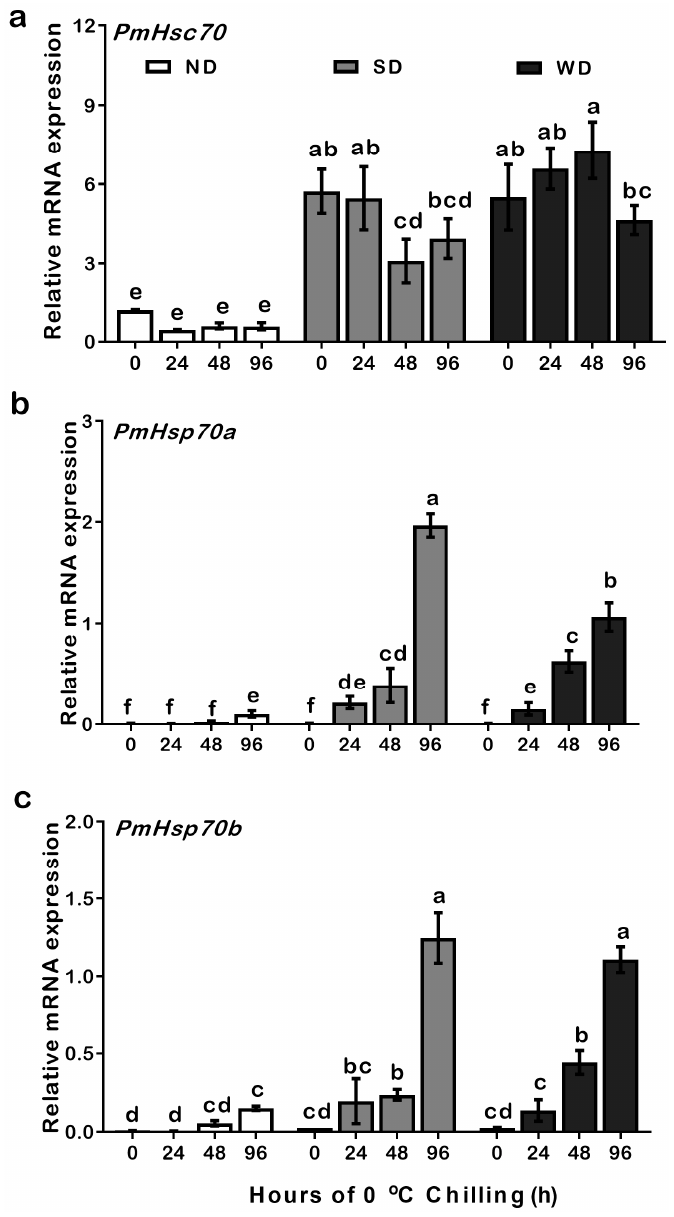
Figure 4. Relative mRNA expression levels of PmHsc70 ( a ), PmHsp70a ( b ), and PmHsp70b ( c ) in re- sponse to low-temperature cryogenic chilling at 0 °C in ND, SD, and WD pupae of Pieris melete . The relative expression levels (Mean ± SE) are normalized to β -actin and 18S rRNA. Letters above the bar indicate significant differences by ANOVA and post hoc Bonferroni multiple comparison test ( p <